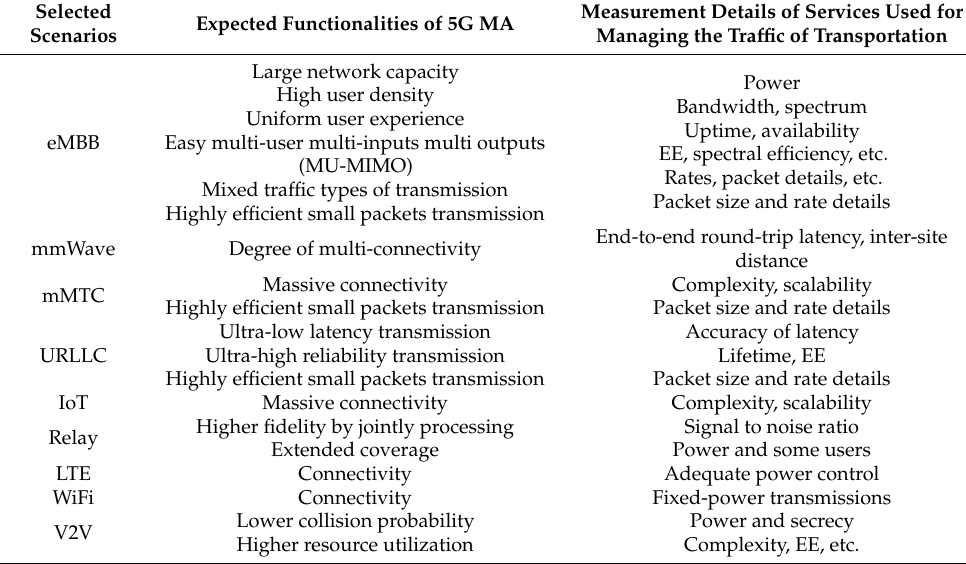
Table 2. Expected functionalities of 5G MA in selected traffic